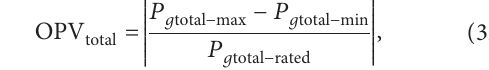
Figure 6: Block diagram of internal structure of central control unit.